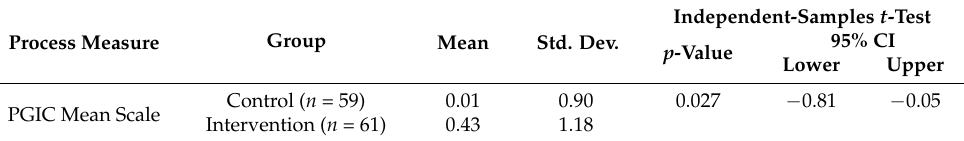
Table 5. Patient Global Impression of Change (PGIC) process measure independent-samples t - test